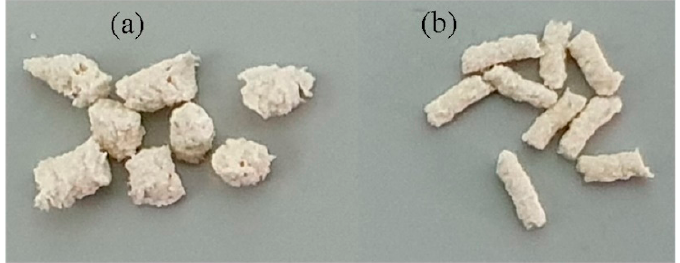
Figure 4. Photographs of fungicide formulations in the form of 1.5-mm ( a ) and 3.0-mm ( b ) granules.